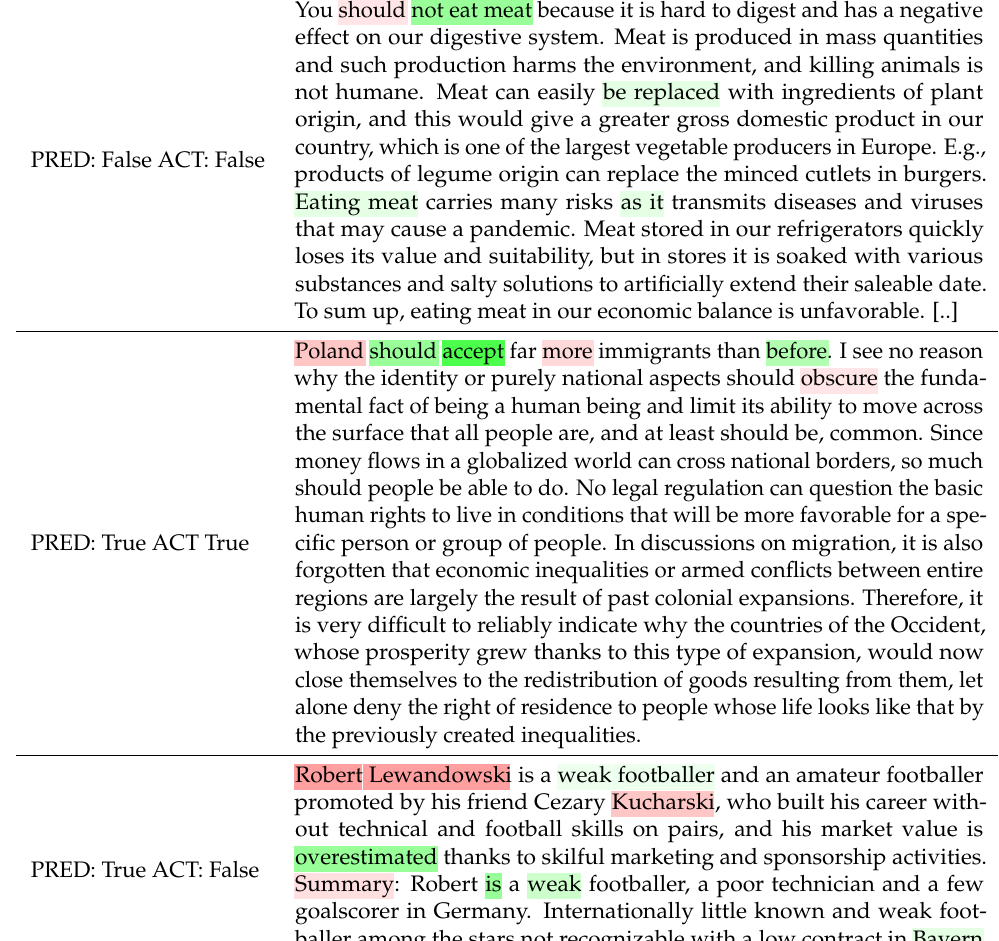
Table 6. Examples of model interpretability. PRED: predicted class, ACT: actual class. Words and phrases that have positive correlations with the true class are shown in green, otherwise red, taking into account the degree of color saturation as an indicator of the strength of the